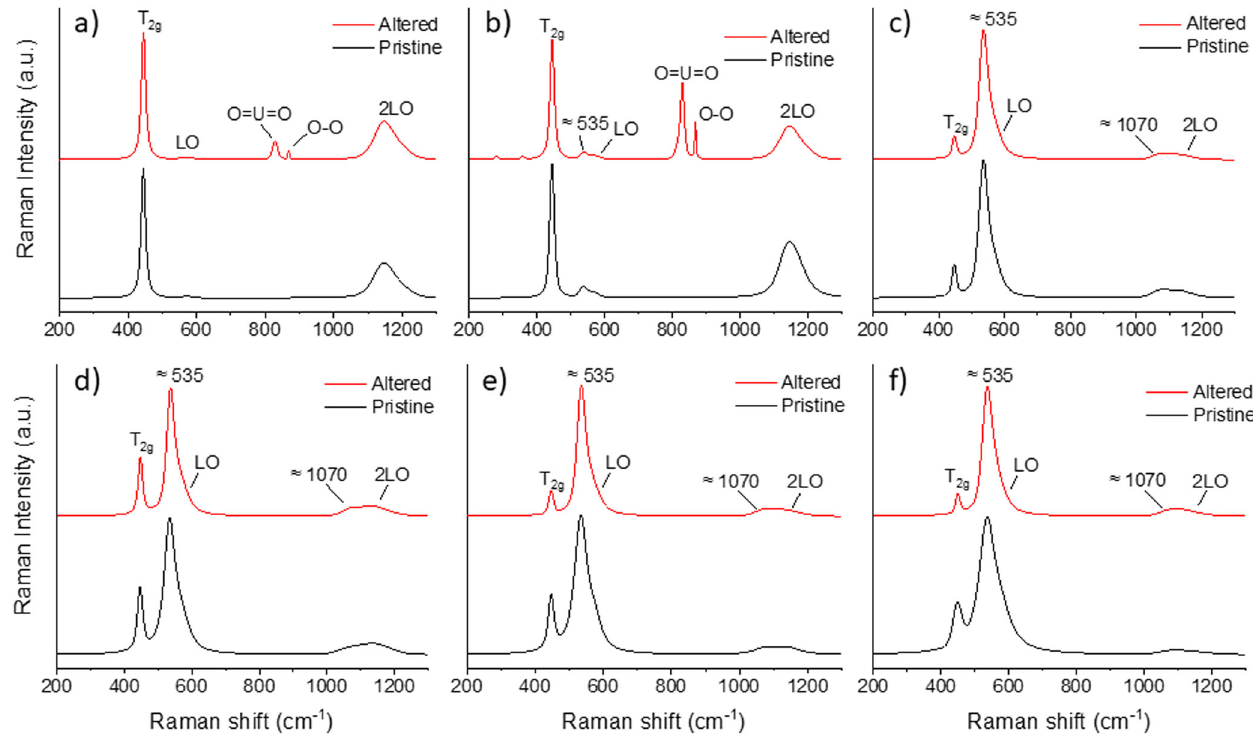
Fig. 7 Raman spectra of altered samples. Raman spectra before and after leaching in 0.20 mmol.L − 1 H 2 O 2 solution of a UO 2 ; b heterogeneous material – UO 2 area; c heterogeneous material – (U,Ce)O 2 area; d U 0.92 Ce 0.08 O 2 ; e U 0.88 Ce 0.12 O 2 ; f U 0.75 Ce 0.25 O 2